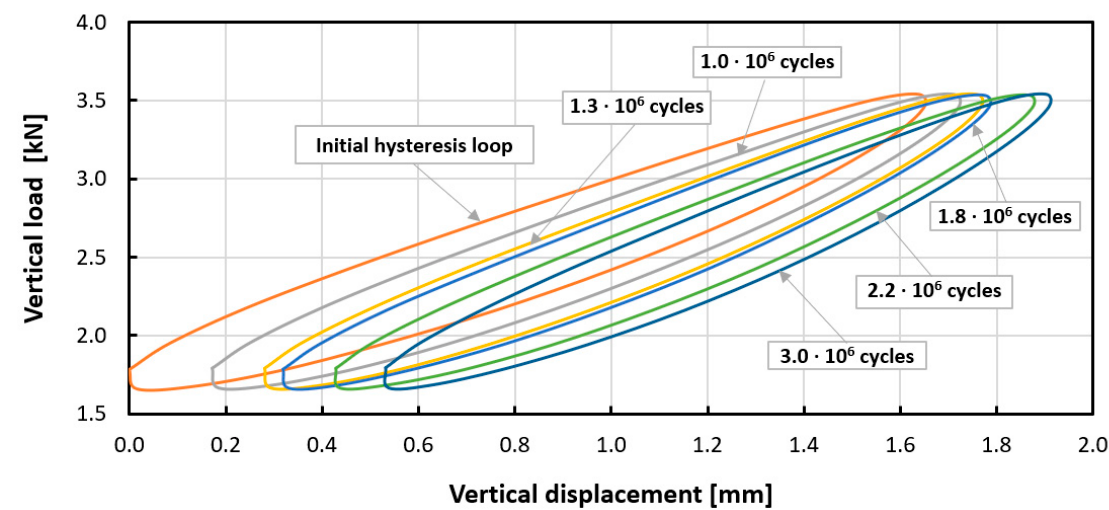
Figure 5. Experimental curves (specimen 3) showing the effect of the number of load cycles on the dynamic mechanical response (C dyn ), cyclic hardening of Mat A.